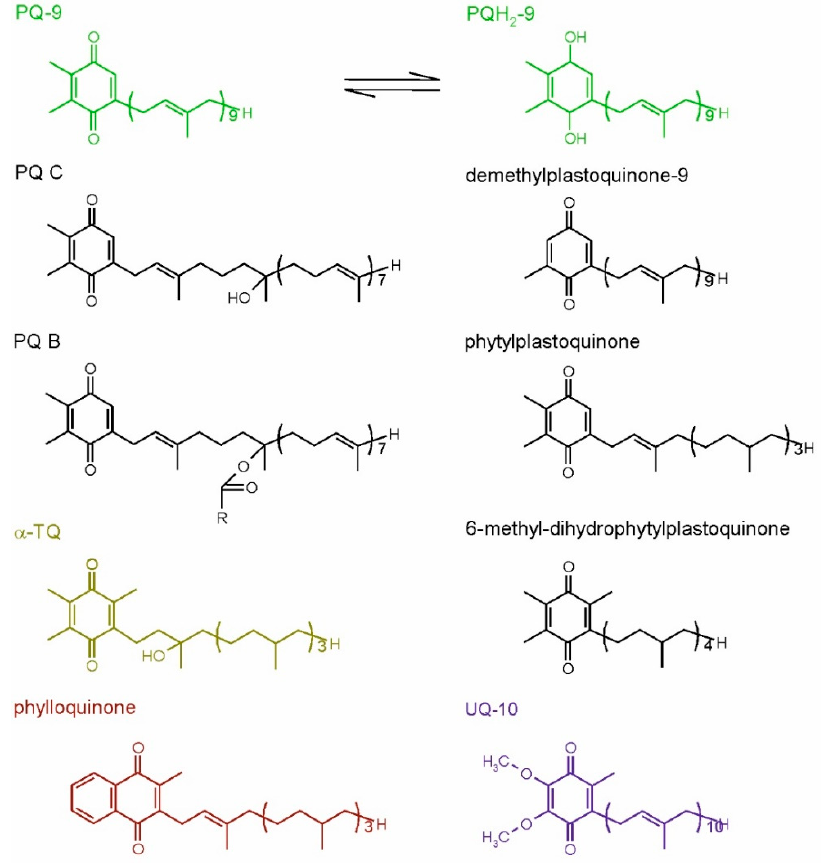
Figure 3. Plant isoprenoid quinones. The common compounds are shown in color, while the examples of rare forms are shown in black. For plastoquinone-9, its reduced, quinol form also is shown. PQ-9, plastoquinone-9; PQ B, plastoquinone B; PQ C, plastoquinone C; PQH 2 -9, plastoquinol-9; R, fatty acid hydrocarbon tail; α -TQ, α -tocopherol quinone; UQ-10, ubiquinone-10.